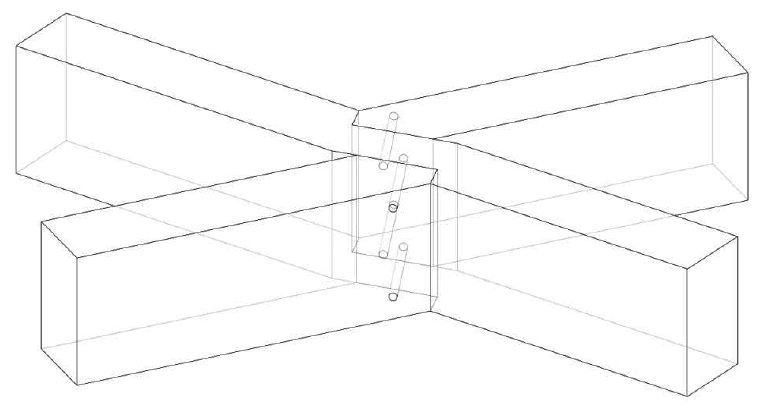
Figure 7. The micro-step joint by the FLEX team. A wood joint reinforced with screws.